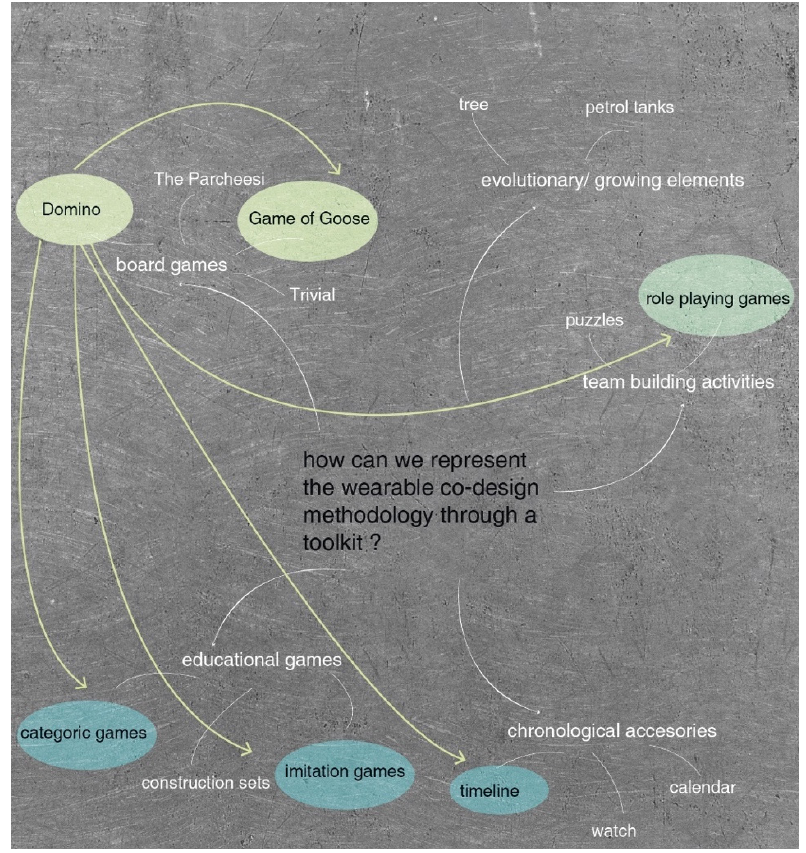
Figure 2. Results from the Brainstorming on the toolkit development.